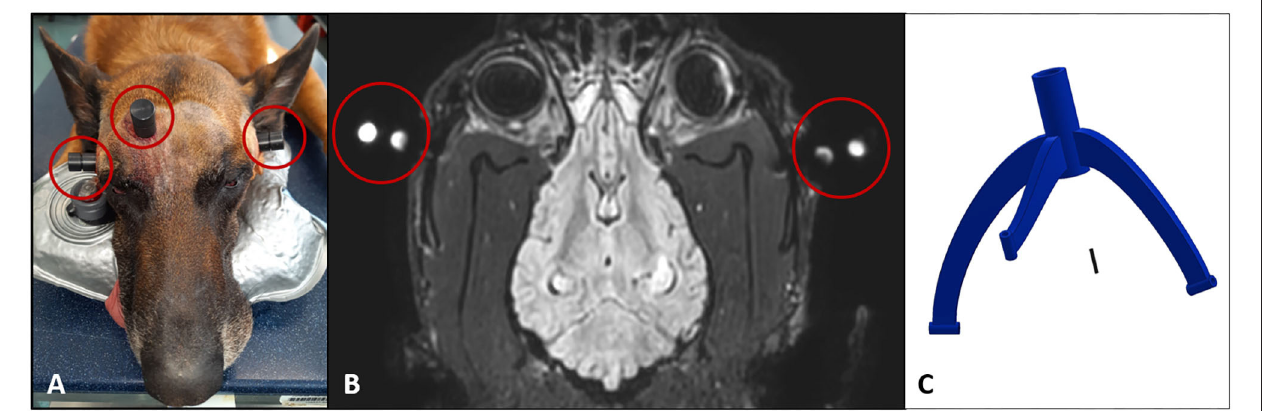
FIGURE 1 | (A) Preparation of the patient for the planning MRI scan. Dog head (case 3) with the three bone anchors and specific MRI markers in place at both zygomatic arches and paramedian over the frontal sinus (red circles). (B) Dorsal T1W MR image of the planning MRI scan for dog 1 with the MRI markers in place (red circles). The MRI markers were made of small plastic that contained two round press fit vitamin D capsules, which were visible in the MR images. (C) The computer-aided construction of the patient-individual brain biopsy device on the basis of the MR images was made by an engineer. The biopsy frame consists of three legs and a biopsy port in prolongation to the biopsy trajectory to the target point in the intracranial